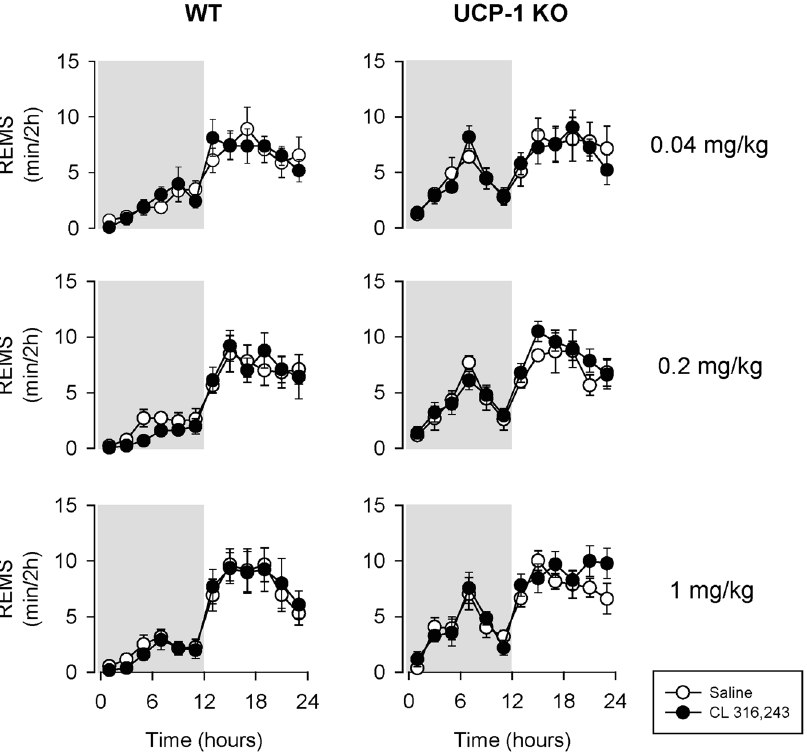
Figure 2. The effects of the selective β 3-AR agonist CL-316,243 on rapid-eye movement sleep (REMS) in WT (left panels) and UCP-1 KO (right panels) mice. See Fig. 1 for details.